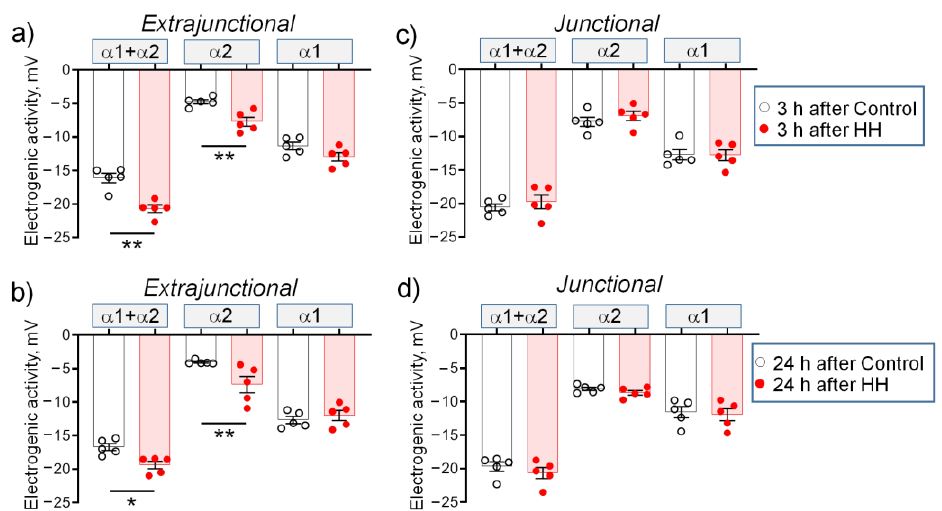
Figure 4. ( a – d ) Electrogenic activity of the α 2 and α 1 Na,K-ATPase isozymes in diaphragm muscles isolated from rats subjected to hypobaric hypoxia (HH) at a pressure equivalent to an altitude of 3000 m for 3 h. The measurements were carried out on muscles isolated 3 or 24 h after control or HH treatment. The electrogenic contribution of the α 2 and α 1 Na,K-ATPase was estimated by administration of 1 or 500 µ M ouabain (as shown in Figure 2a–d). The number of muscles corresponds to the number of symbols. The measurements were carried out in extrajunctional ( a , b ) and junctional ( c , d ) sarcolemmal regions. Two-way ANOVA followed by Bonferroni multiple comparisons test. * p < 0.05, ** p < 0.01— compared to the corresponding control.